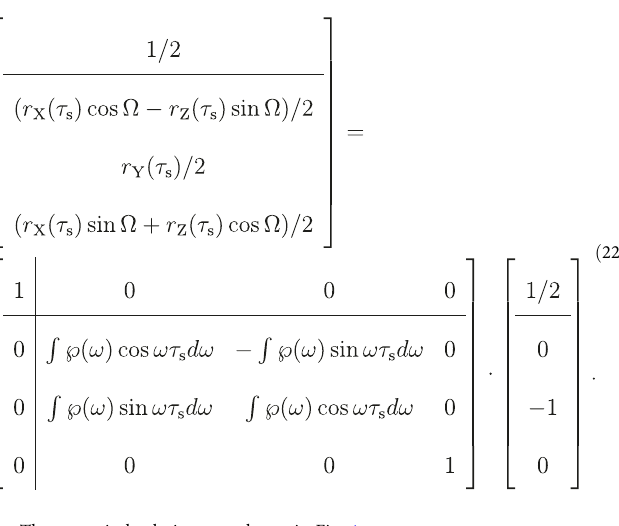
The numerical solutions are shown in Fig. 4c. Further schematic illustration of the simulation and detailed analysis of the effects of noise are given in Supplementary Note